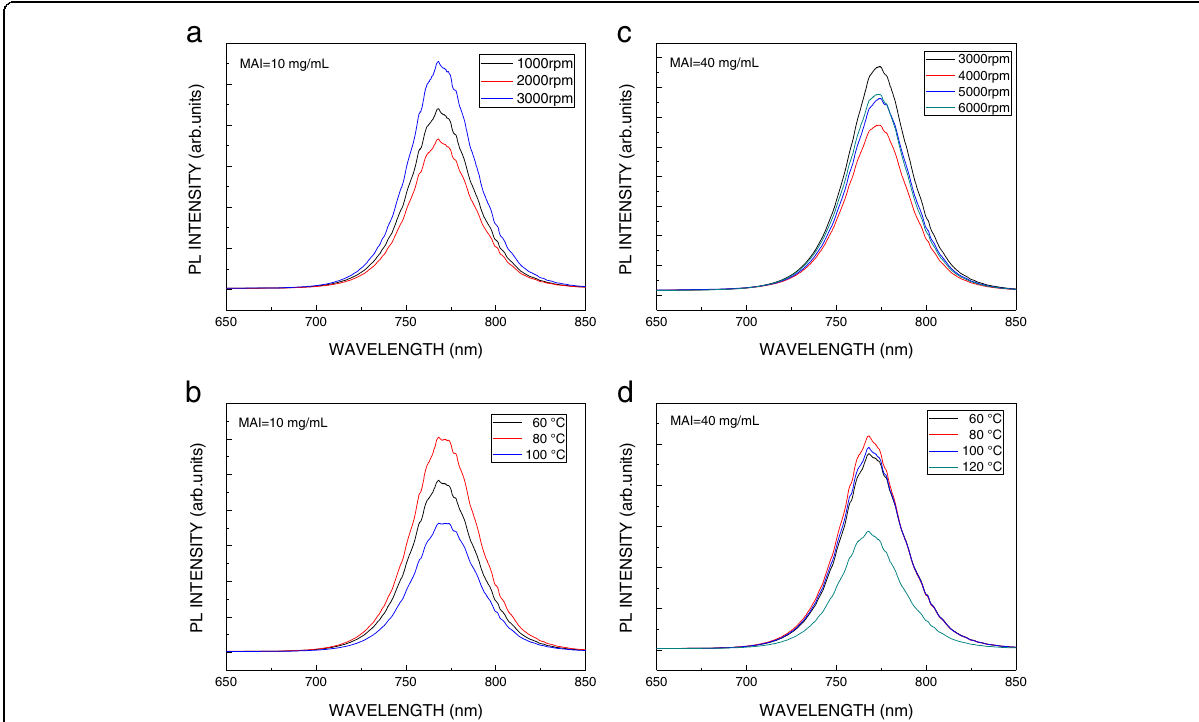
Fig. 5 PL spectra of MAPbI 3 prepared by low-concentration MAI with a various spin coating speeds and b annealing temperatures and prepared by high-concentration MAI with c various spin coating speeds and d annealing temperatures